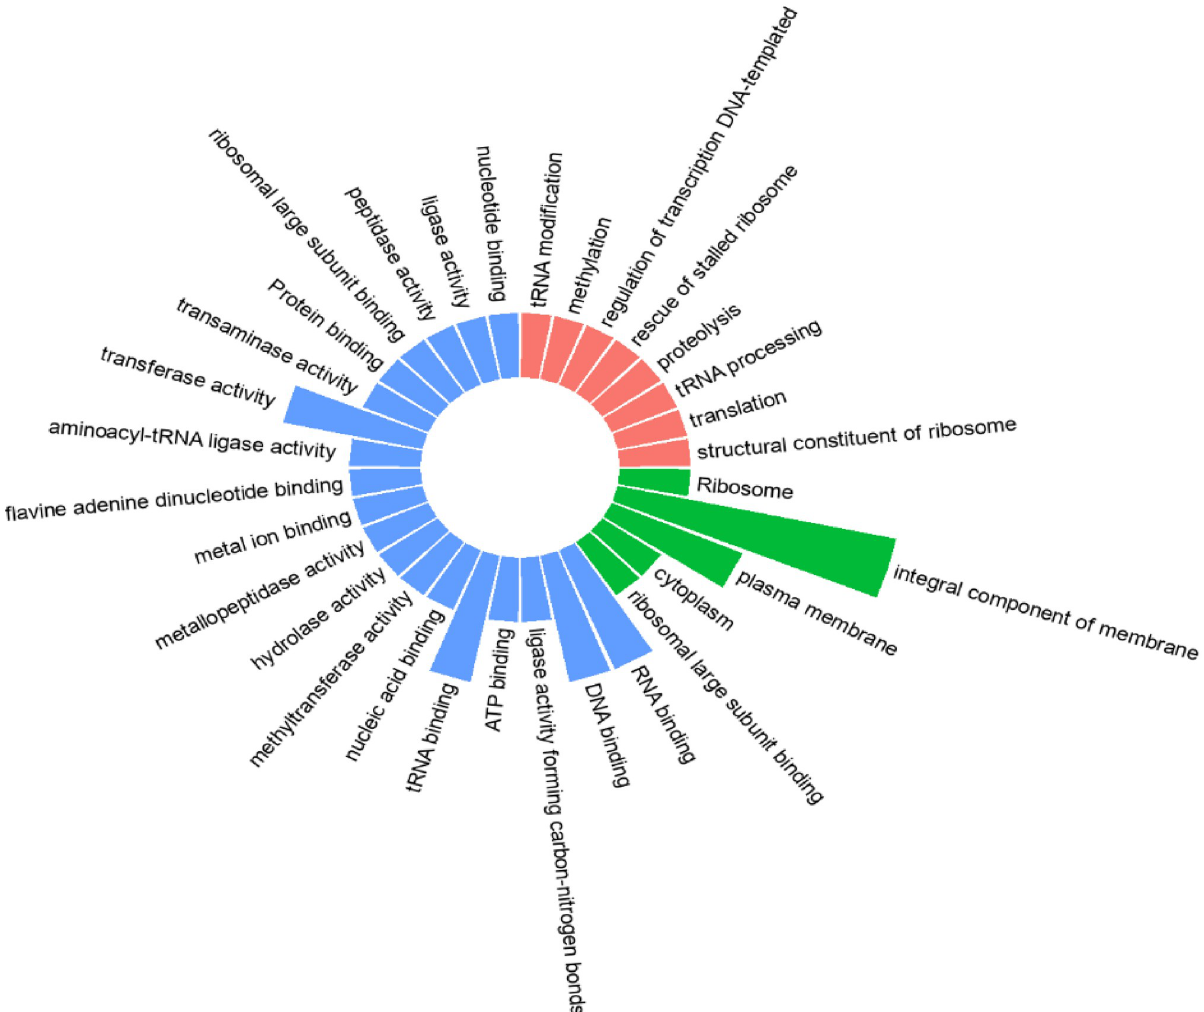
Fig 3. Categories of annotated S . pneumoniae hypothetical proteins classified according to their biological, molecular, and cellular functions. Proteins involved in molecular functions were relatively higher compared to others.